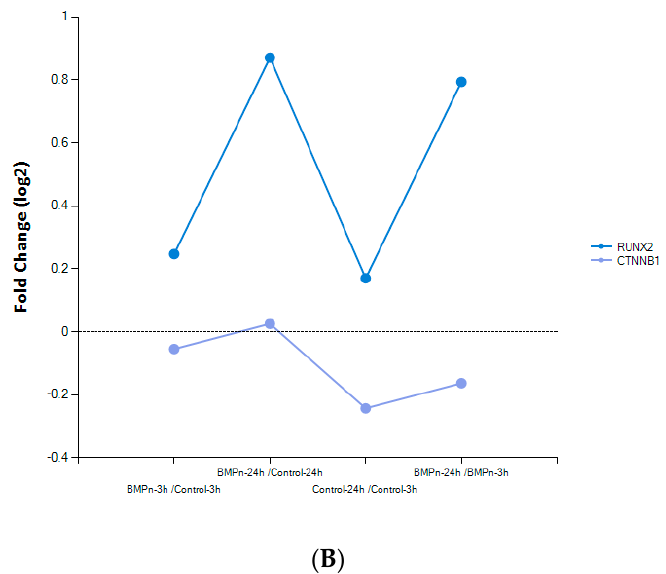
Figure 6. ( A ) Log2-normalized read counts regarding the expression of RUNX2 and CTNNB1 (for β -catenin expression) and ( B ) Log2 fold change regarding the expression of RUNX2 and CTNNB1.